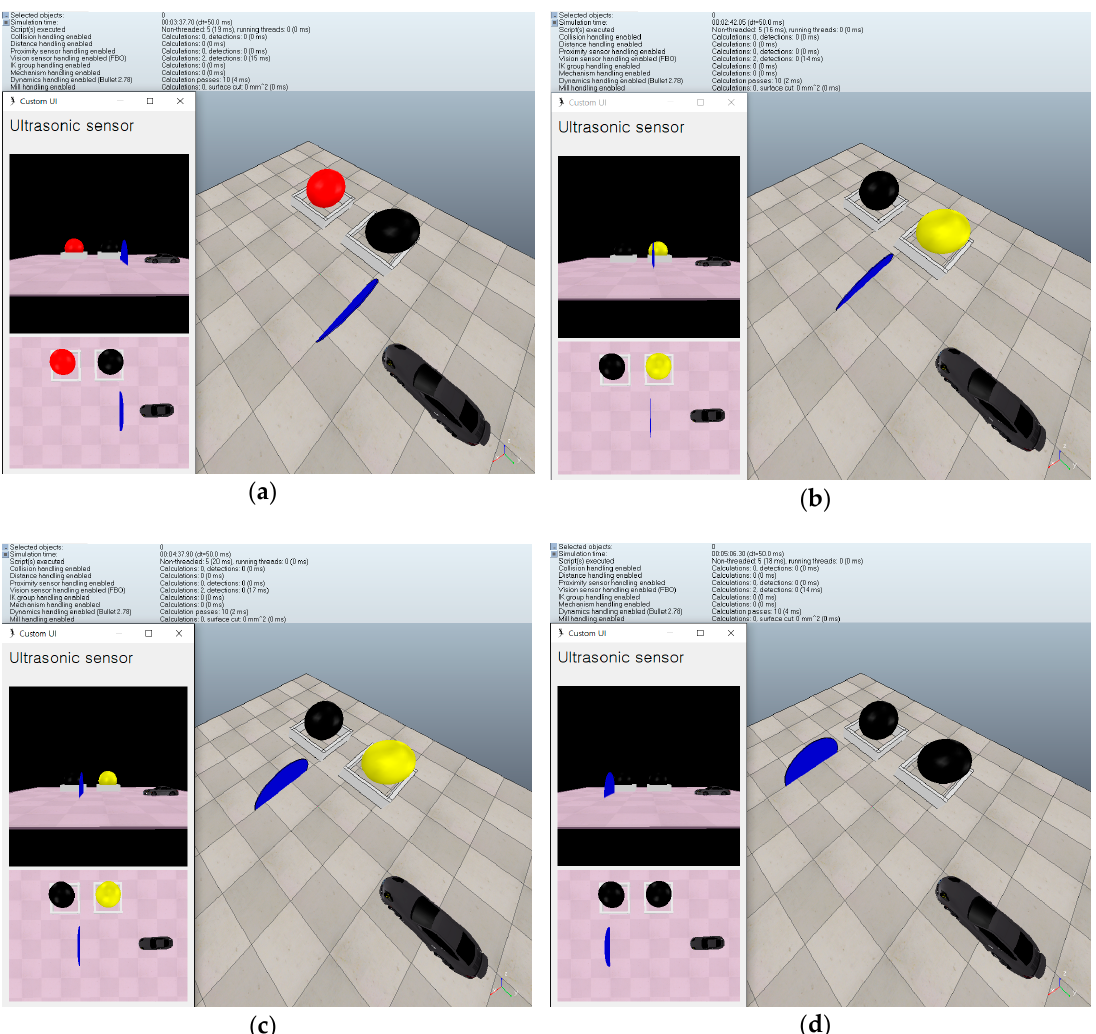
Figure 8. State when the detection distance is: ( a ) 0.5 m; ( b ) 1.0 m; ( c ) 1.5 m; ( d ) 2.0 m.